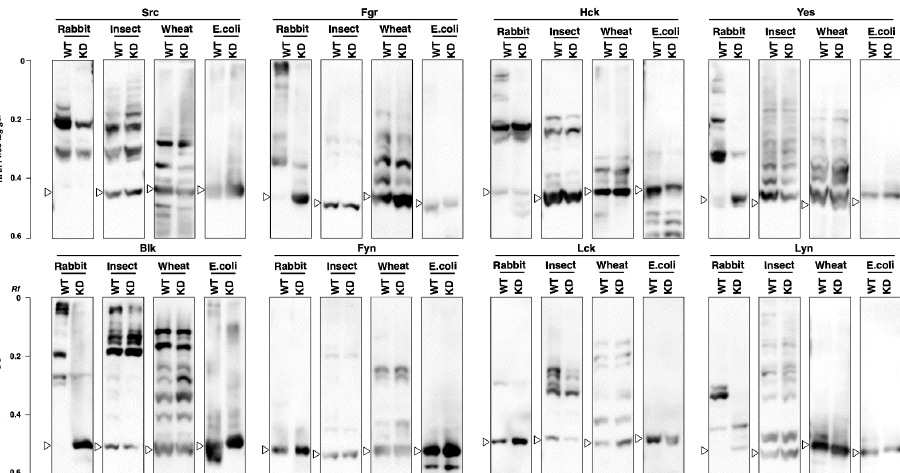
Figure 5. Phosphorylation status of the wild-type (WT) SFKs and the corresponding kinase-dead (KD) mutants produced by the T N T SP6 Quick Coupled Transcrip- tion/Translation System (a rabbit reticulocyte lysate system), the T N T T7 Insect Cell Extract Protein Expression System, the T N T SP6 High-Yield Wheat Germ Protein Ex- pression System), and the S30 T7 High-Yield Protein Expression System ( E. coli lysate system) was analyzed by Phos-tag SDS-PAGE (7% w / v polyacrylamide, 20 µM Zn 2+ – Phos-tag), followed by Western blotting with anti-FLAG antibody. The open arrowheads show the positions of the unphosphorylated forms.